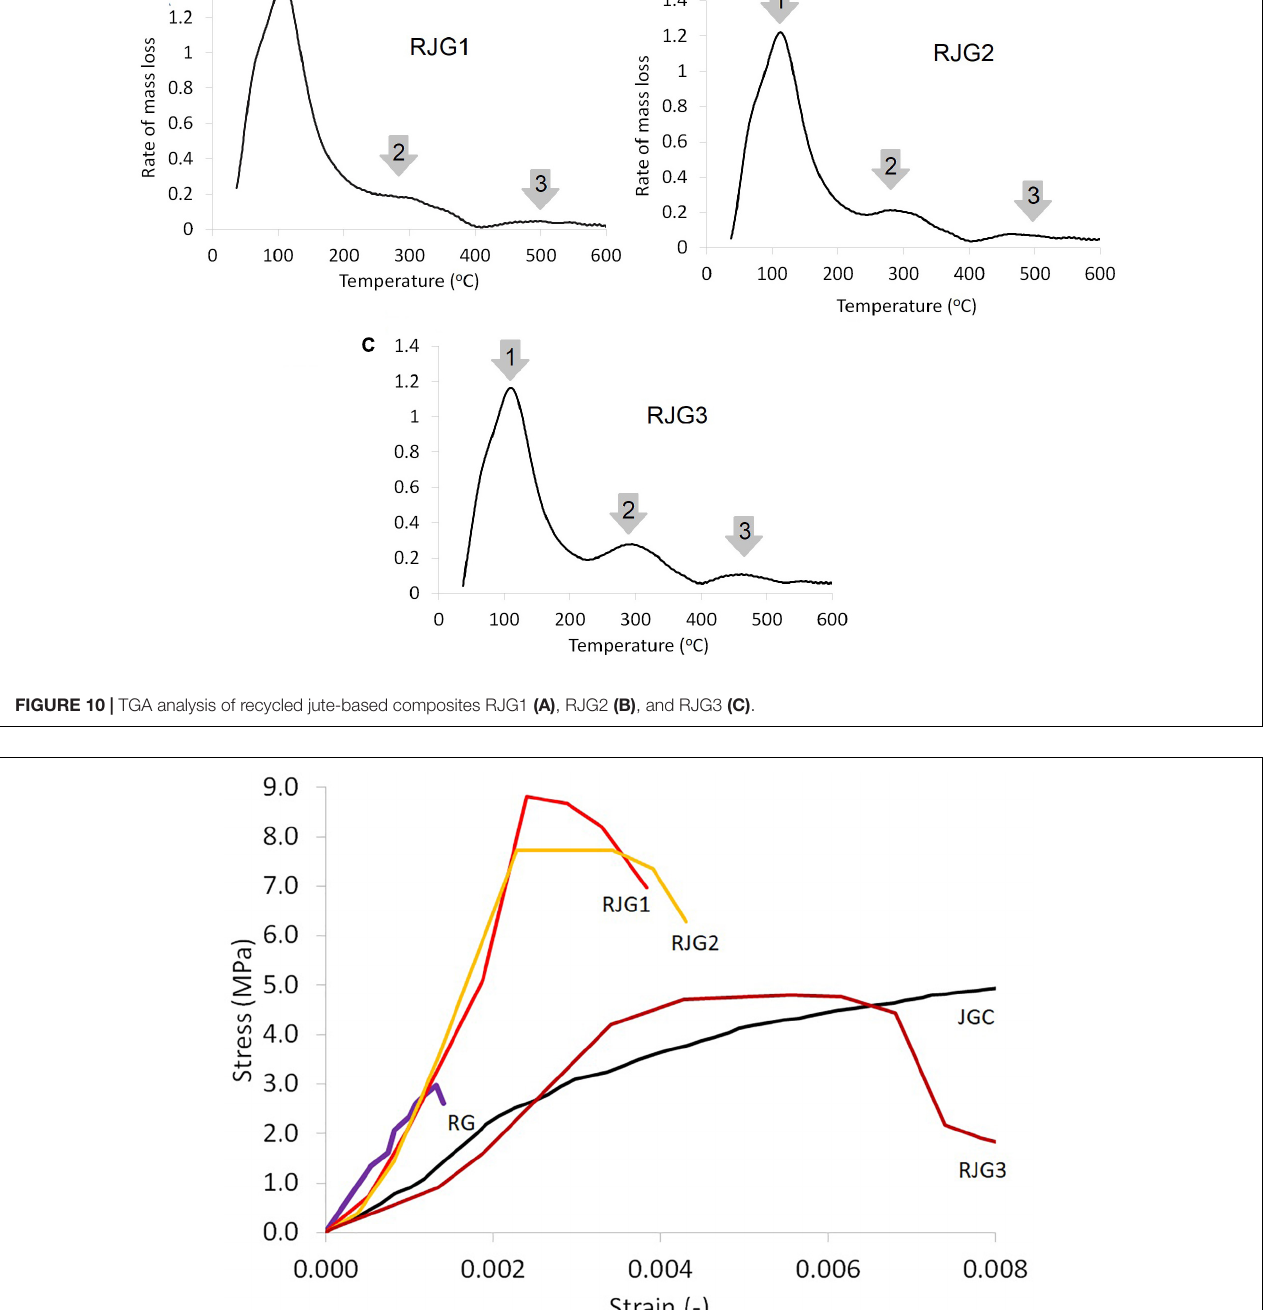
(Correia et al., 2013), causing the ductile failure illustrated in Figure 8A . The alkaline geopolymerization treatment of jute fibers moreover causes the fibrillation of fiber to small fibrils